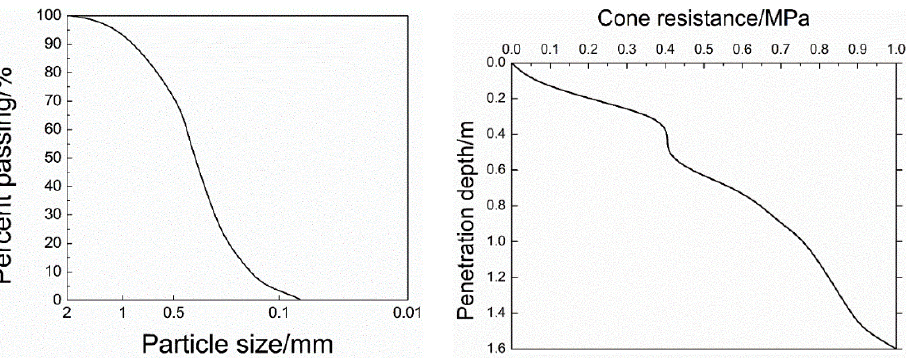
Table 3. Soil parameters.